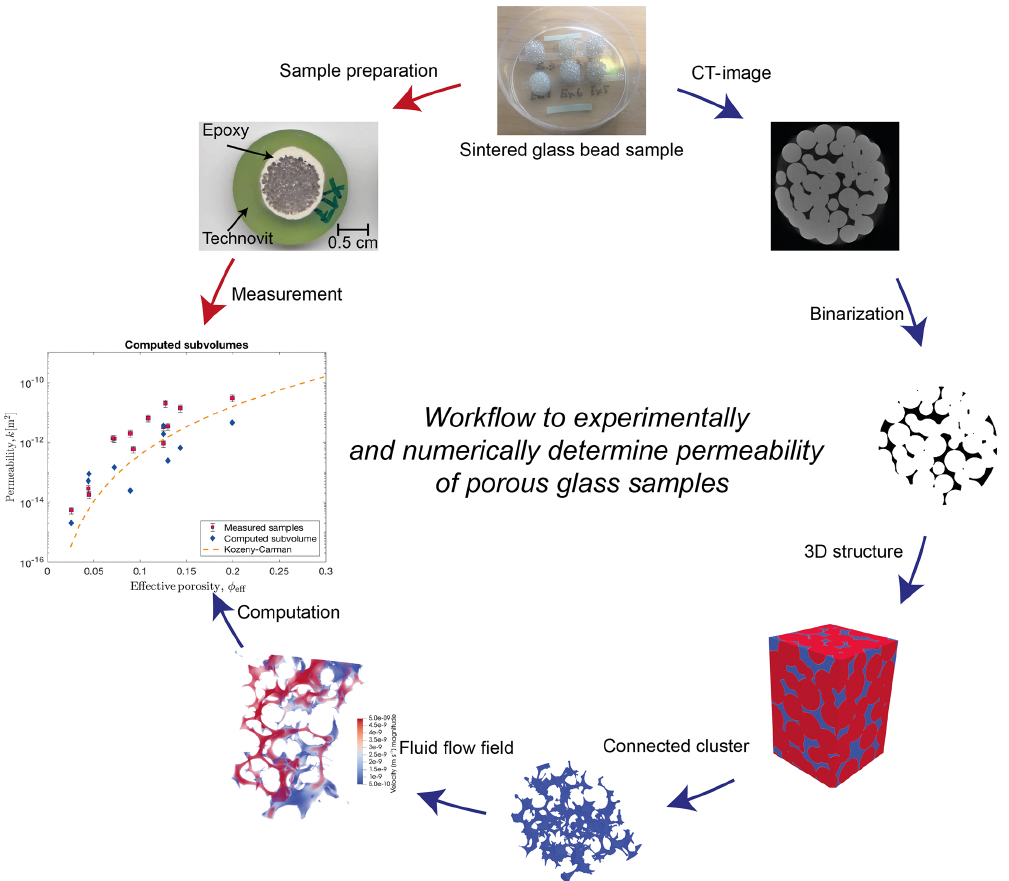
Figure 1. Workflow process map – red arrows mark the experimental workflow, whereas blue arrows indicate the numerical workflow.